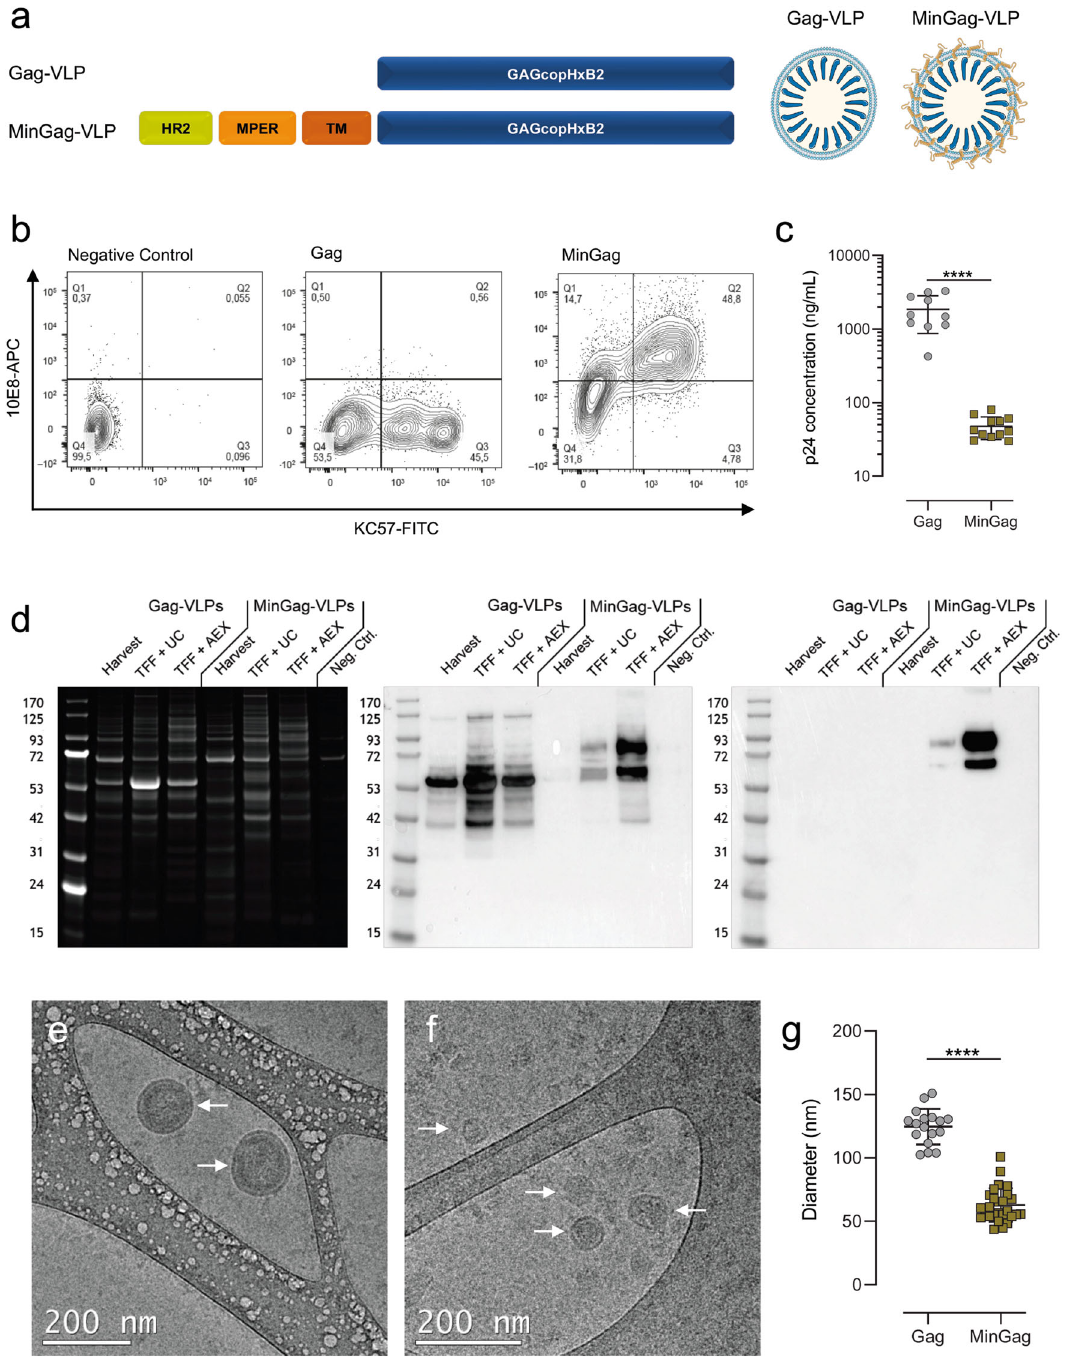
Fig. 1 Characterisation of high-density HIV-1 Gag-based VLP production in Expi293F cells. a Schematic representation of the constructs and hypothetical structure of Gag-VLPs and high-density MinGag-VLPs. Min is a gp41-derived protein that contains a fragment of the HR2, MPER and TM domains. b FACS dot plots for the staining of non-transfected (left), gag -transfected (middle) and mingag -transfected (right) Expi293F cells stained with the anti-p24 KC57-FITC-conjugated mAb (X-axis) and the anti-MPER 10E8 antibody ( Y axis). c Quanti fi cation of p24 by ELISA on harvested supernatants of gag -transfected and mingag -transfected Expi293F cells. Data represented as mean ± SD. Signi fi cant differences on production were found using a Mann – Whitney U test (**** p < 0.0001). d Characterisation of HIV-1 Gag-VLPs and MinGag-VLPs from harvested supernatants and after puri fi cation with either sucrose-cushion ultracentrifugation (TFF + UC) or anion exchange chromatography (TFF + AEX) by Coomassie blue staining (left), anti-p24 WB (middle) and anti-2F5 WB (right). Both western blots correspond to the same gel. Uncropped images are shown at Supplementary Fig. 2a. e Cryo-EM of puri fi ed Gag-VLPs. Scale bar = 200 nm. f Cryo-EM of puri fi ed MinGag-VLPs. Scale bar = 200 nm. g Diameter comparison of Gag-VLP ( n = 17) and MinGag-VLP ( n = 27). Signi fi cant differences on size were found using a Mann – Whitney U test (**** p < 0.0001). Data represented as mean ±